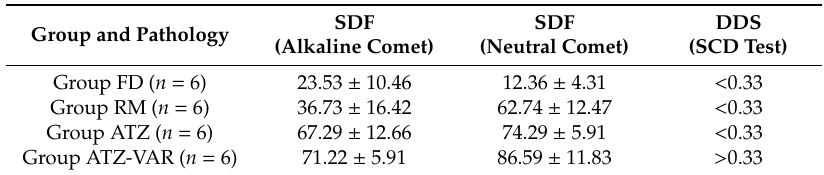
Table 1. Percentage of spermatozoa showing DNA fragmentation assessed by the Comet assay and Sperm Chromatin Dispersion (SCD) test (mean ± standard deviation).